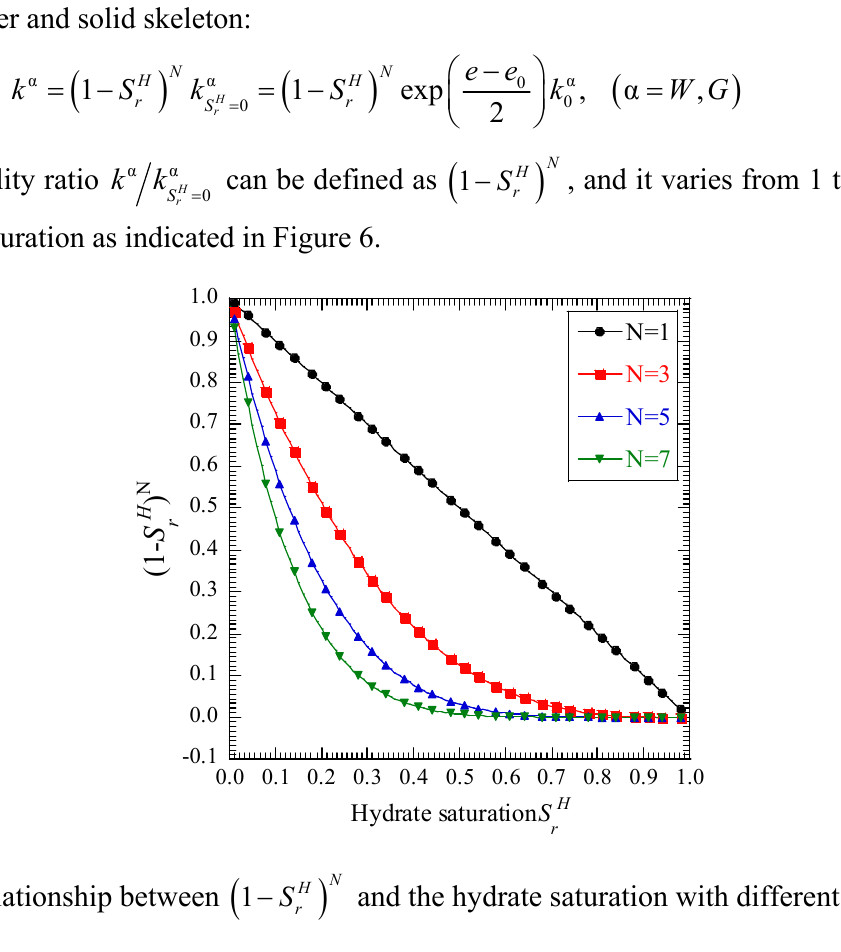
Figure 6. Relationship between   1